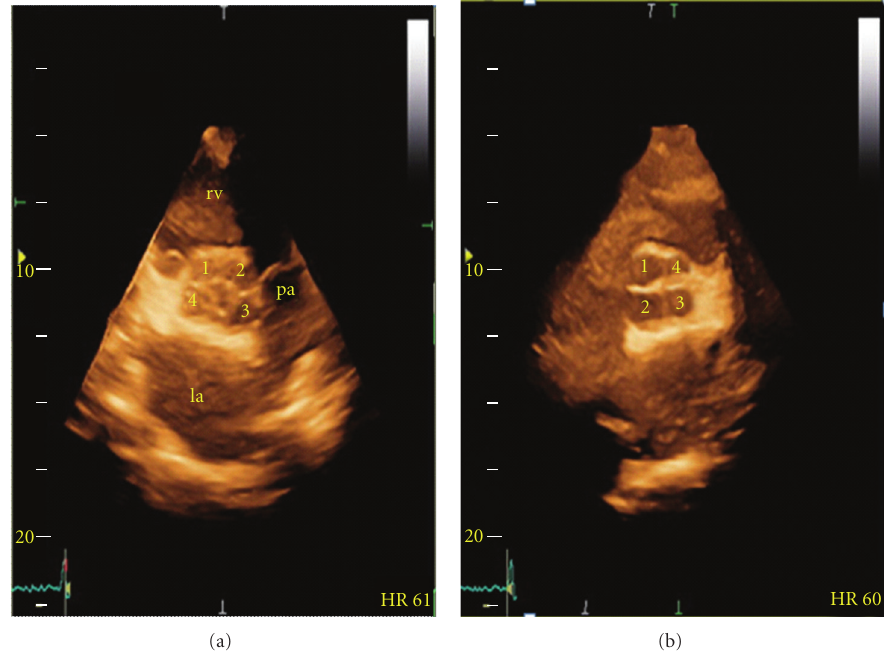
Figure 2: 3-dimensional transthoracic echocardiography images. Short axis view during early systole (a) and diastole (b). pa: pulmonary artery, la: left atrium, and rv: right